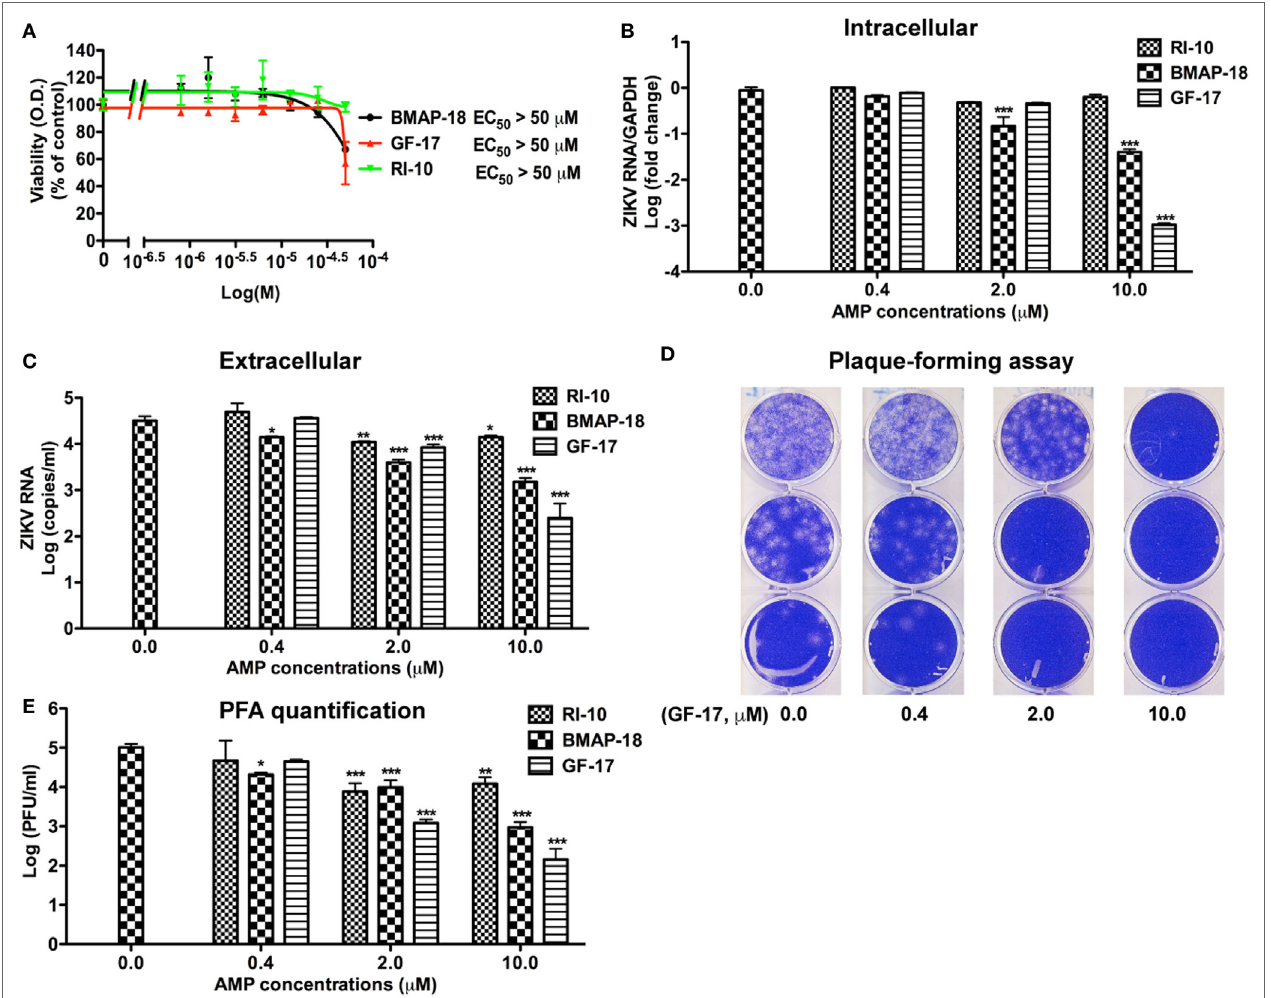
FigUre 3 | Antimicrobial peptides derived from cathelicidins inhibit Zika virus (ZIKV) infection in human fetal astrocytes. (a) Human fetal astrocytes were treated with doses of the selected peptides ranging from 1 to 50 µM. After 24 h, the cultures were washed and treated with same doses of peptides in fresh medium for another 24 h. Cell viability was determined by a colorimetric MTS assay. Results shown are the averages ± SD of experiments performed in triplicate. Data were analyzed by nonlinear regression and assessed the EC50 for each of the antimicrobial peptides. (B–e) Astrocytes were treated with doses of antimicrobial peptides ranging from 0.4 to 10 µM for 2 h then infected with ZIKV at the MOI of 0.5. After 24 h, the cultures were washed and treated with same doses of antimicrobial peptides in fresh medium for another 24 h. At the experimental endpoint, intracellular ZIKV RNA (B) was determined through real-time RT-PCR in total cellular RNA. Data were normalized to GAPDH and presented as fold change (in log scale) compared with ZIKV group. Extracellular ZIKV RNA [ (c) , in log scale] was determined through real-time RT-PCR using total RNA isolated from cell-free supernatants. ZIKV virion levels (in log scale) were determined by adding cell-free culture supernatants to Vero cells and overlaid with Agar gel in viral PFA (D) . Viral plaques were manually counted and calculated as PFU/mL (e) . * p < 0.05, ** p < 0.01, and *** p < 0.001, as compared with the ZIKV group without peptide treatment (ANOVA, N =